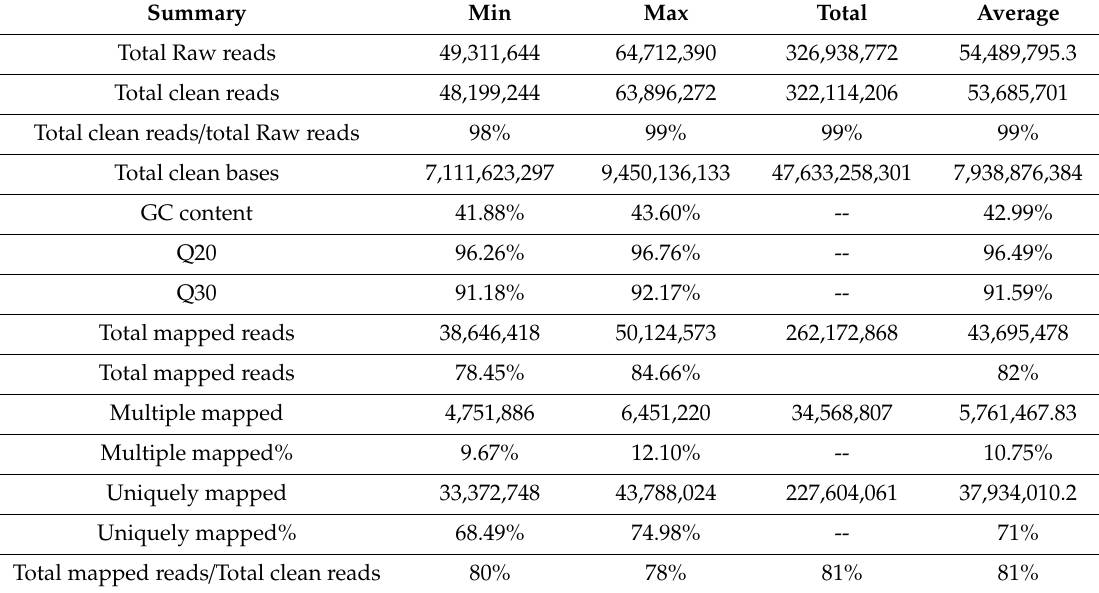
Table 1. Descriptive statistical analysis of